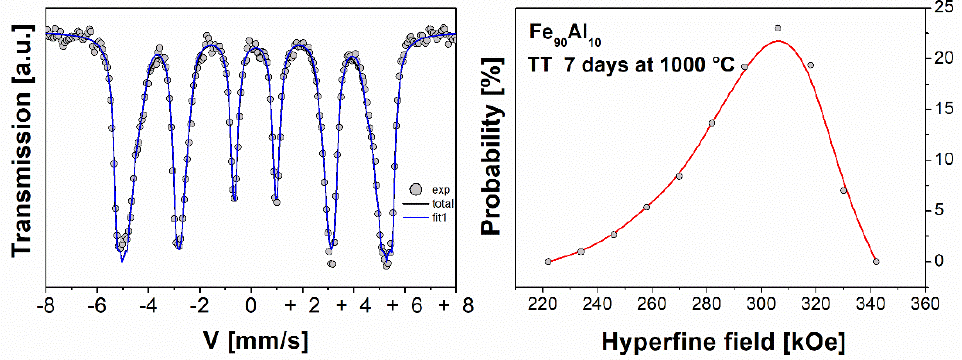
Figure 3. Mössbauer spectra and its corresponding probability distribution of the Fe 90 Al 10 system with thermal treatment (TT) at 1000 °C for 7 days.